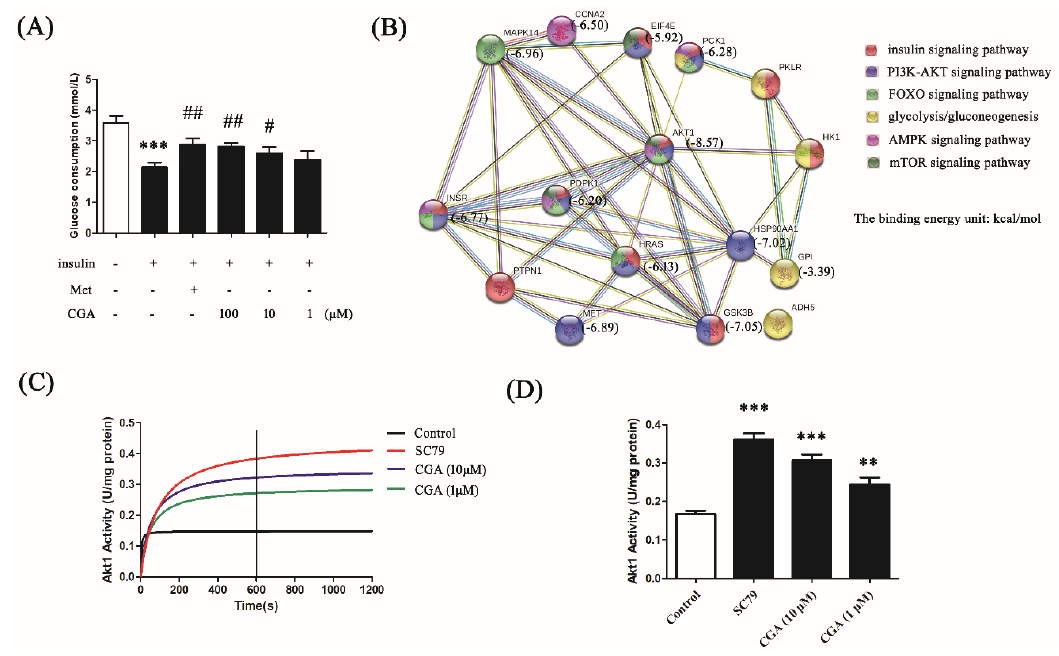
Figure 1. The effects of chlorogenic acid (CGA) on the regulation of glucose consumption and the prediction of its target proteins. ( A ) Effects of different concentrations of CGA on glucose consumption in insulin-treated HepG2 cells. Metformin hydrochloride (Met) served as a positive control. Each bar represents the mean ± standard error of the mean (SEM). +: with; -: without. *** p < 0.001 vs. control; # p < 0.05 vs. model; ## p < 0.01 vs. model ( n = 6). ( B ) Prediction of the targets of CGA using PharmMapper and analysis of the interaction and signaling on potential target proteins using String v9.1. ( C ) The enzymatic activity of protein kinase B (AKT) in HepG2 cells after treatment with different concentrations of CGA. SC79 was used as a positive control. ( D ) The histogram presents the activities of AKT at 600 s after the respective treatments. Each bar represents the mean ± SEM. ** p < 0.01 vs. control; *** p < 0.001 vs. control ( n =